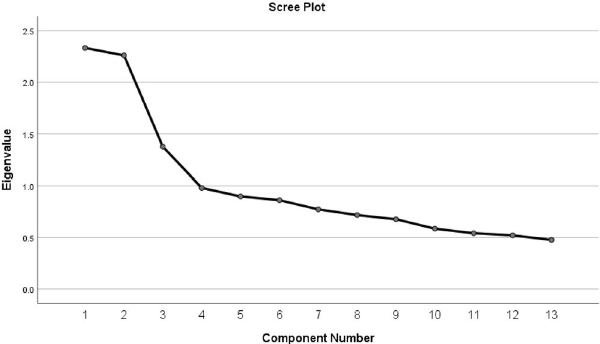
Figure 6. Four components were chosen from the screen plot following a PCA on the answers to 13 thought- related questions. For this study, only the first component (task-related thought) was used for analysis.